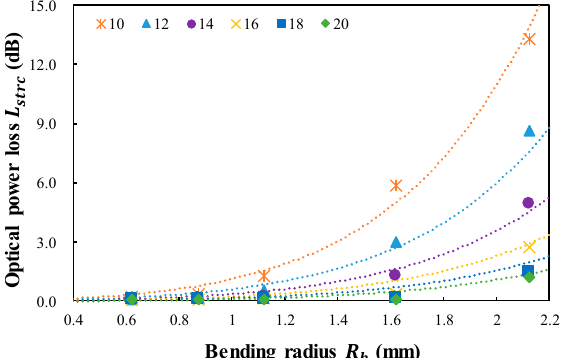
Figure 5. Calculated optical power loss ( L strc ) versus bending radius ( R b ) for six distances between steel wires ( d wire ) of the twisted dual-cycle bending structure.